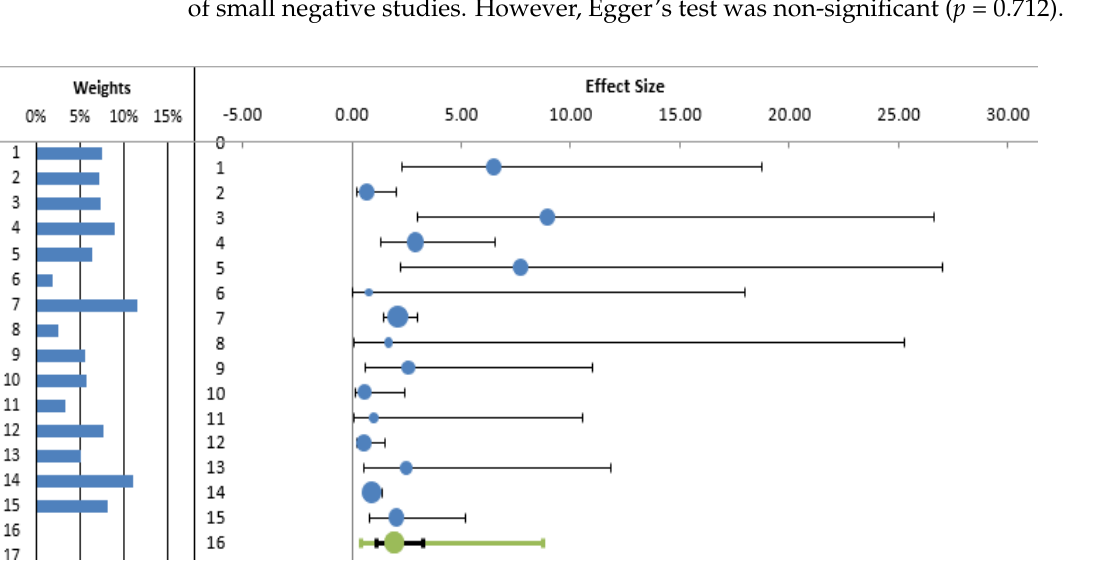
Figure 3 . Publication bias. Funnel plot of studies reporting LD (diagnosed by antibodies) associated with occupational exposure. To interpret the heterogeneity observed, we analyzed the studies on forestry workers and farmers separately from the other categories. The estimated OR in forest and agricul- tural workers in comparison with controls was 2.36 (CI95% 1.28; 4.34), while there was a non-significant increase in risk (OR = 1.05, CI95% 0.28; 3.88) in the remaining categories of workers (veterinarians, animal breeders, and soldiers). (Table 3, Figure 4). Table 3. Comparison of Forester and farmers with other categories of exposed workers.